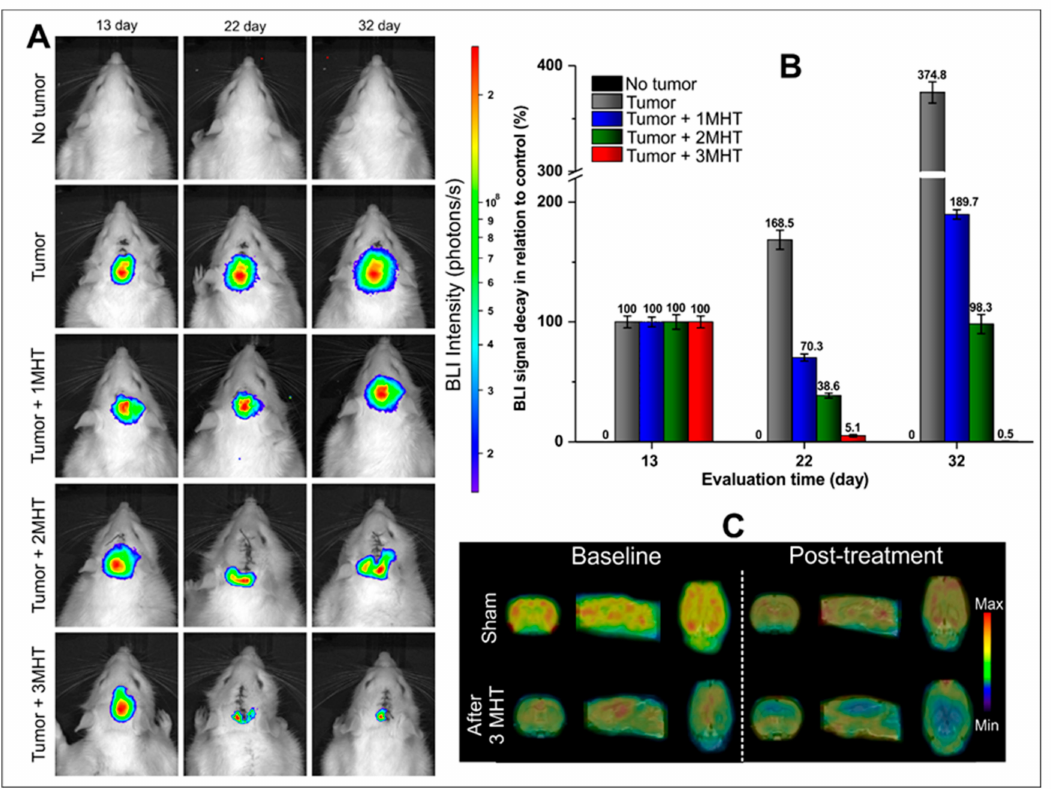
Figure 7. Evaluation of the MHT therapeutic process in multiple applications by BLI and 18 F-FDG-PET. ( A ) BLI images of experimental groups at 13th (baseline), 22nd, and 32nd day after tumor induction, BLI signal changes according to the number of MHT applications. ( B ) Evaluation of BLI signals percentual after multiple applications of MHT therapeutic process. ( C ) Illustrative 18 F-FDG-PET images fused to MRI templates of animals not submitted to tumoral induction (sham), animals submitted to tumor induction after three MHT applications, before (baseline) and post-treatment through 18